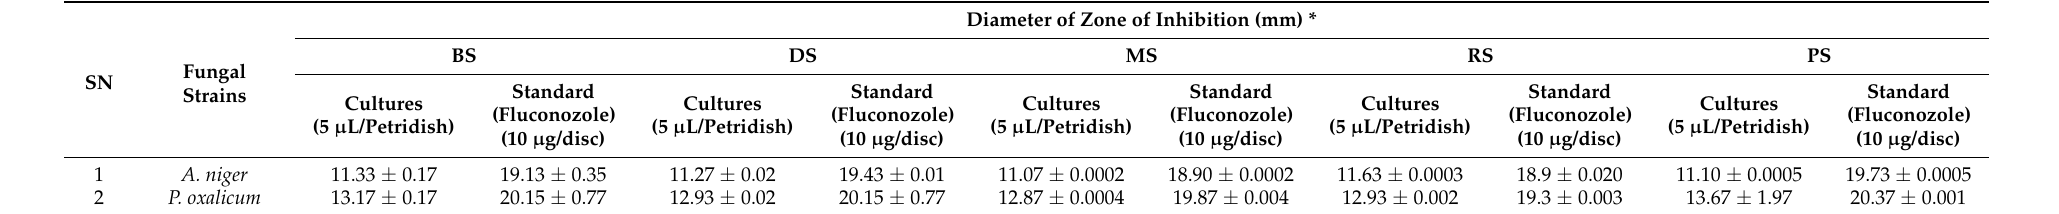
Table 4. Antifungal activity of hog plum ( Spondias mombin L.) peel oil extracted from different regions of